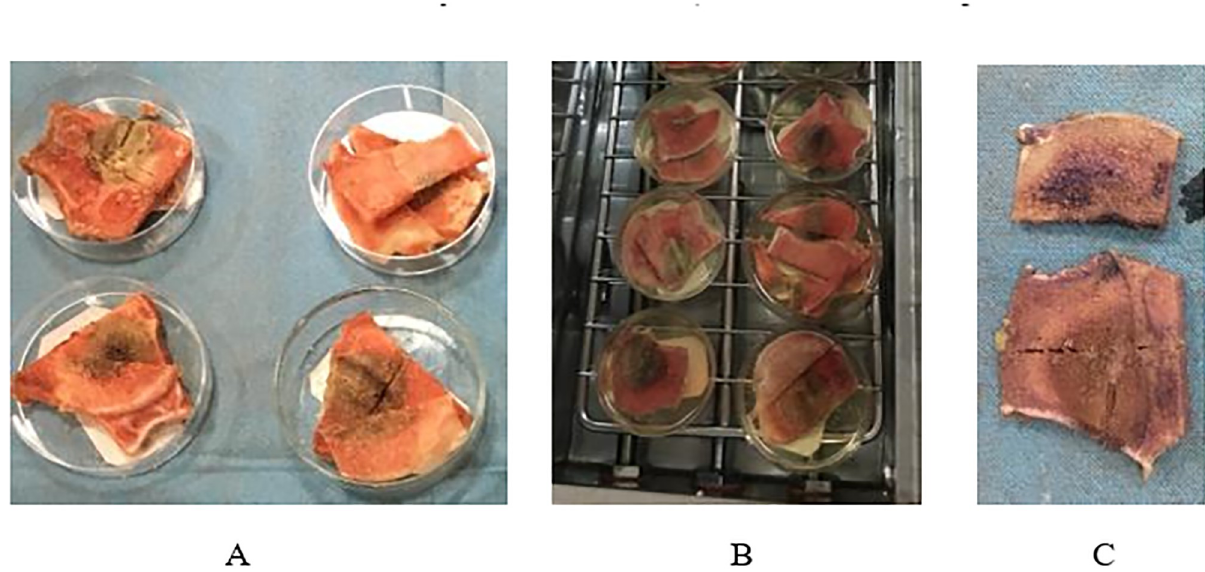
Fig 3. Staining of sheep proximal femur metaphysis samples after ablation. A. Samples before staining. B. Samples in the incubator. C. Sample after staining in Nitro-BT solution.